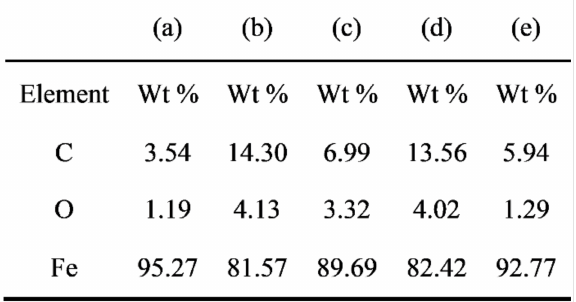
Figure 12. Representative EDS spectra of unpainted substrate and laser treated samples: ( a ) un- painted substrate; ( b ) in compressed air, focusing; ( c ) in compressed air, defocus distance +4 mm; ( d ) in inert atmosphere, focusing; ( e ) in inert atmosphere, defocus distance +4 mm.